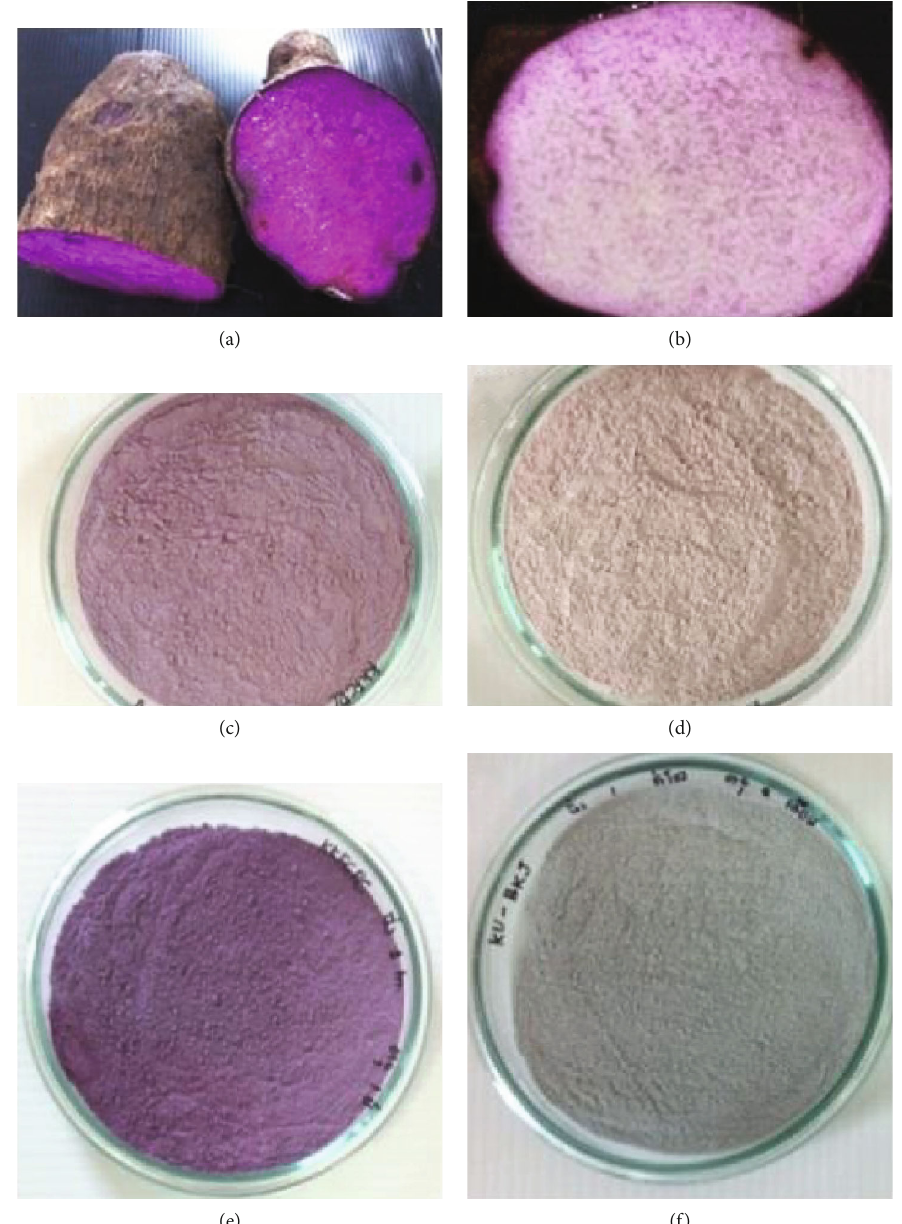
Figure 5: E ff ect of steaming tuber before milling on the colour of yam fl our from KKFCRC (a, c, e) and BKJ (b, d, f) tubers: (a, b) fl esh tuber colour, (c, d) fl our prepared directly from tubers, and (e, f) fl our prepared from steamed